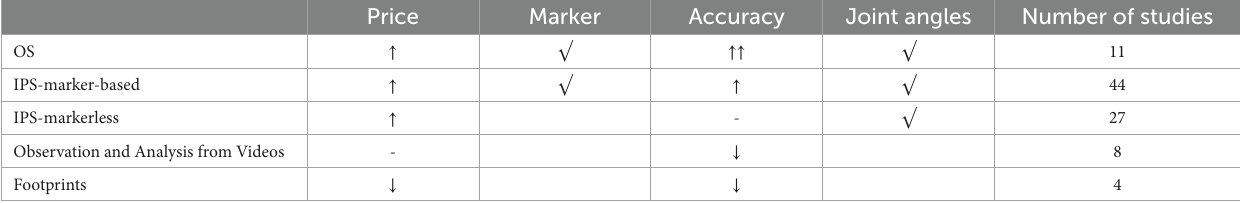
TABLE 1 MoCap systems in NHP studies.